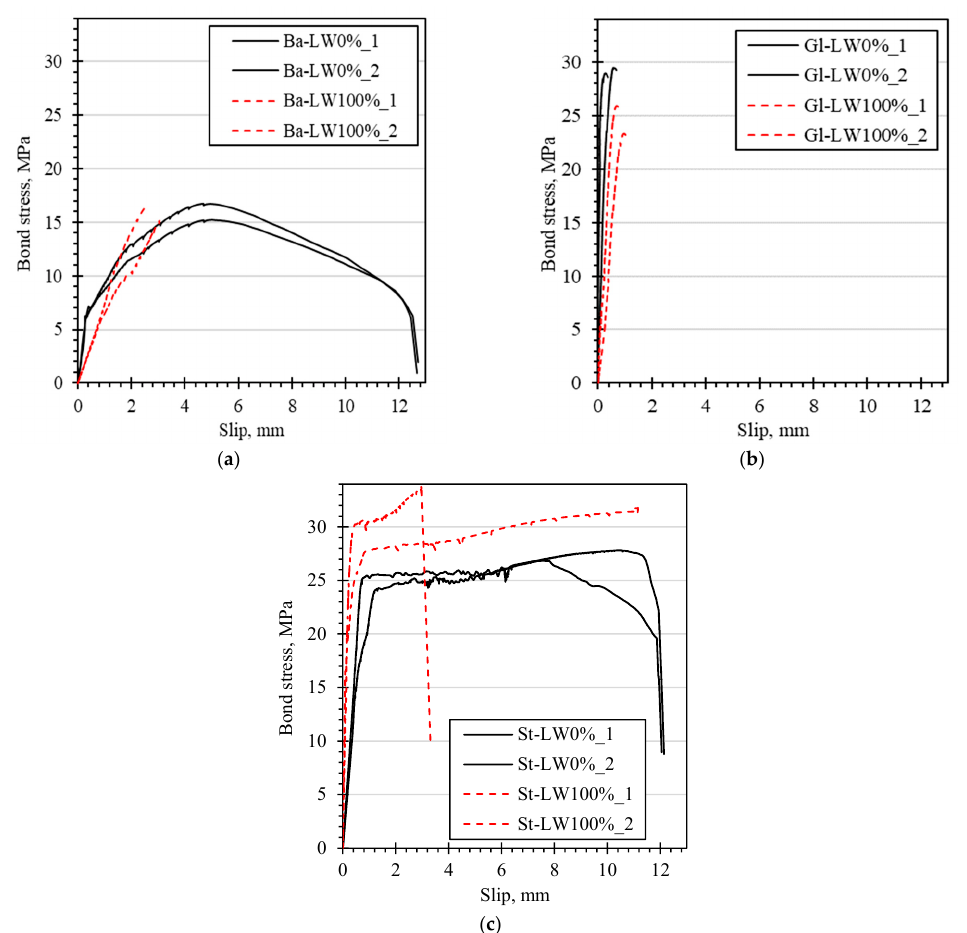
Figure 8. Bond stress–slip (loaded end) diagrams of different bars: ( a ) BFRP with a helically wrapped surface, ( b ) GFRP with a helically wrapped and sand coated surface, ( c ) steel ribbed surface.